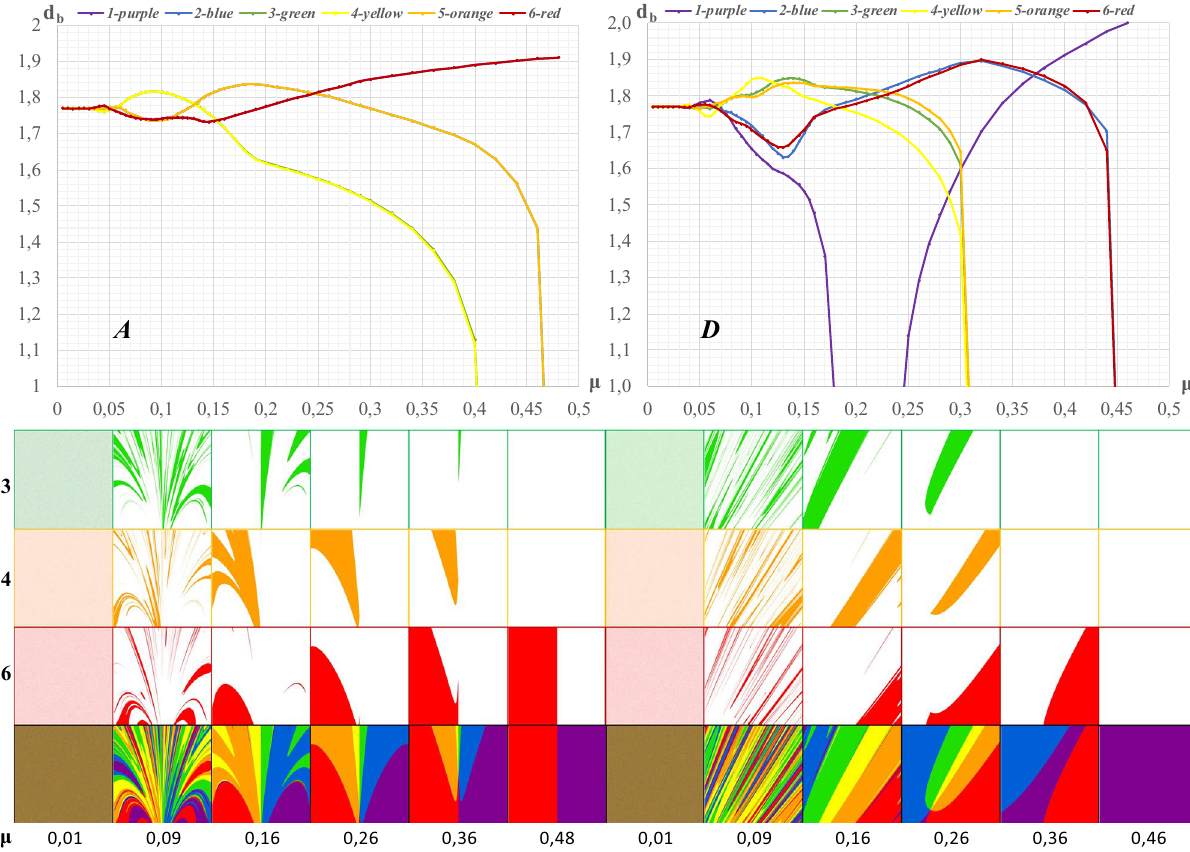
Figure 8. Local dimensions of parts of the attraction basins treated as an irregular geometric figure in ( A ) and ( D ). Legend: The icons illustrate the variability of the shape of some of the attraction basins of individual cities in fragment ( A ) and ( D ) for cities 3, 4 and